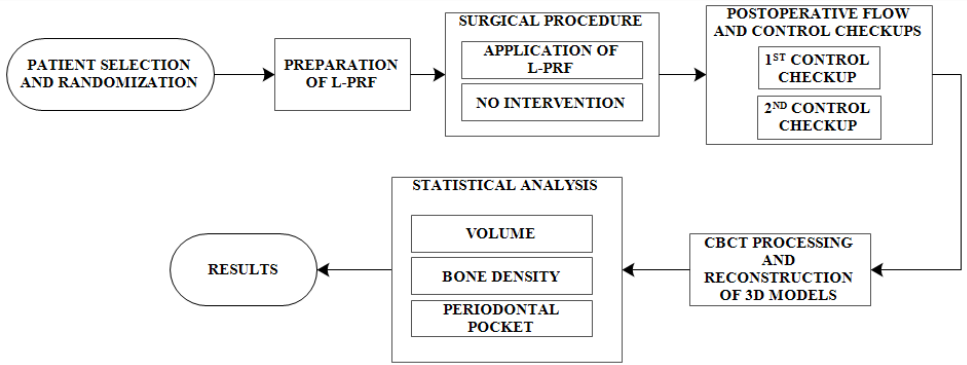
Figure 1. Methodology workflow.